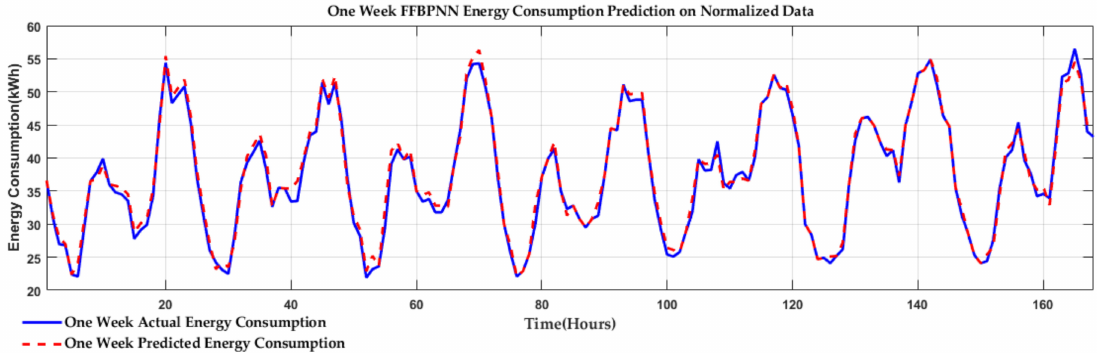
Figure 16. One-week hourly energy consumption prediction using FFBPNN on normalized